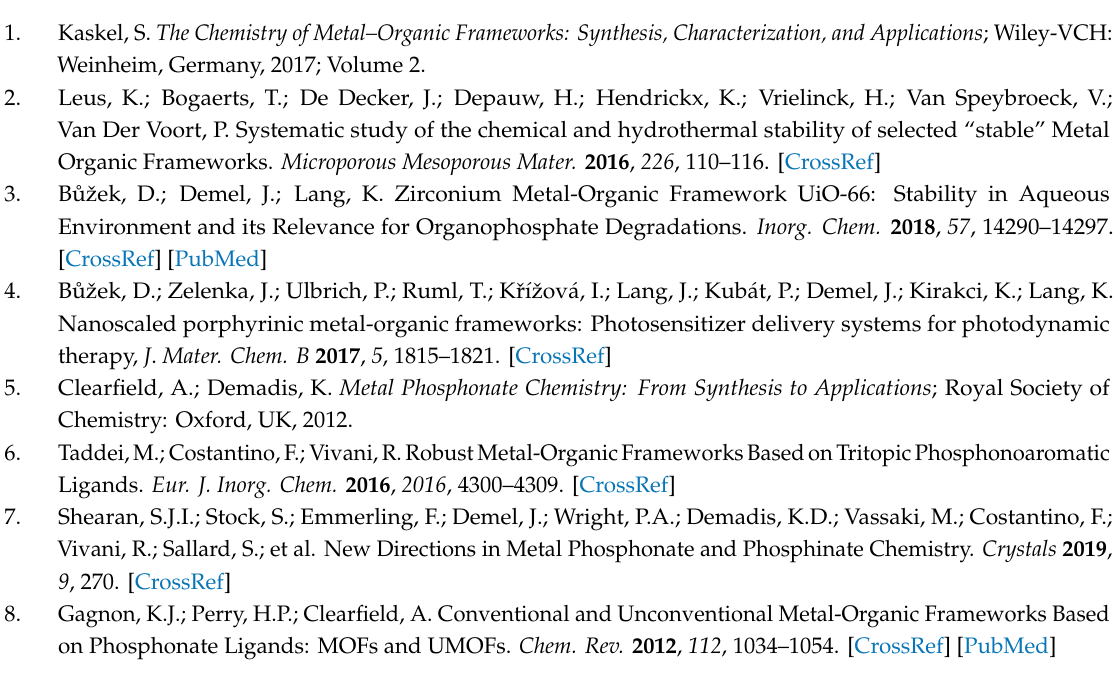
Figure S1: Rietveld fit of ICR-9Cryst. Figure S2: Powder XRD pattern of the sample prepared by the defective procedure with a reaction time of 3 h. Figure S3: Pore size distribution of ICR-9A. Figure S4: Pore size distribution of ICR-9B. Figure S5: DTA / TGA curves and the evolution of gases for ICR-9Cryst. Figure S6: DTA / TGA curves and the evolution of gases for ICR-9A. Figure S7: DTA / TGA curves and the evolution of gases for ICR-9B. Figure S8: Assignment of 31 P peaks in the solid state NMR spectra. Figure S9: FTIR spectra of ICR-9Cryst, ICR-9A, and ICR-9B. Table S1. Crystallographic details of